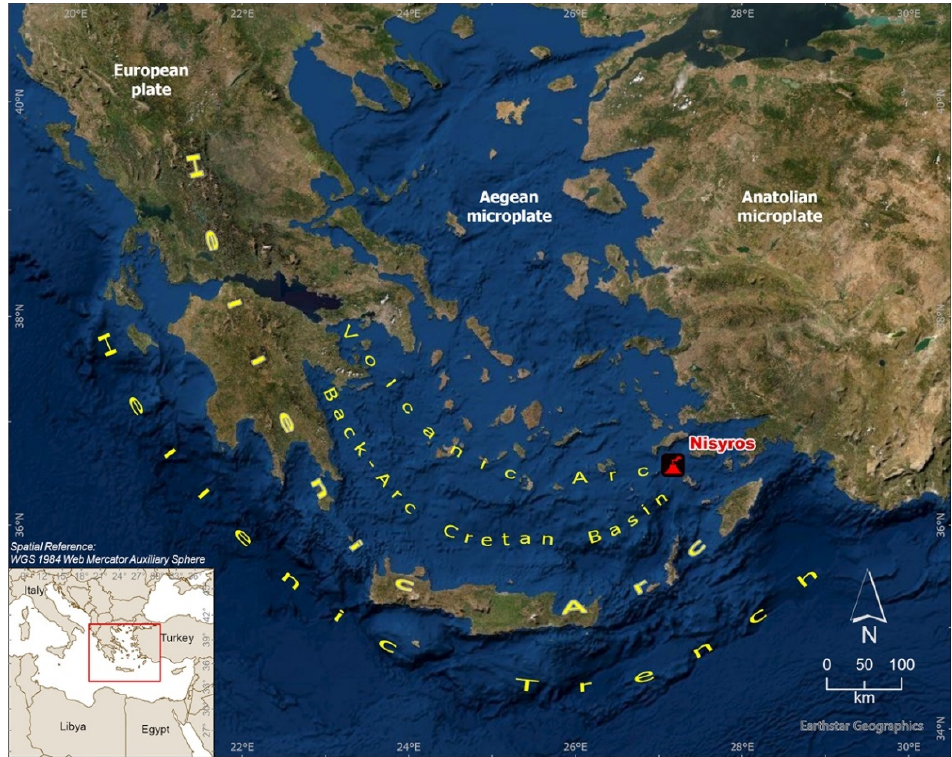
Figure 1. A simplified map showing the location of Nisyros Volcano in the South Aegean Volcanic Arc.